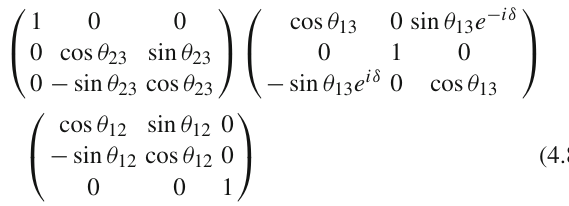
m ν 1 = 0 . 01 eV including normal and inverted mass ordering. The blue (red) lines are the model predictions for the muon decays for inverted (normal) neutrino mass hierarchies. The difference between the solid and dashed lines is the absolute mass for the neutrino flavor ν 1 . For instance, the red solid line in the left-panel of Fig. 1 accounts for the BR (μ → e γ ) for m ν 1 = 0 . 01 eV within a normal mass ordering. The gray region represents the region currently excluded by LHC based on the search for doubly charged scalars within a type II seesaw framework with normal mass ordering. The dashed and dotted vertical gray lines are the HL-LHC and HE-LHC projected exclusion limits. The black horizontal lines are the current and projected bounds on the μ → e γ (left-panel) and μ → 3 e (right-panel)